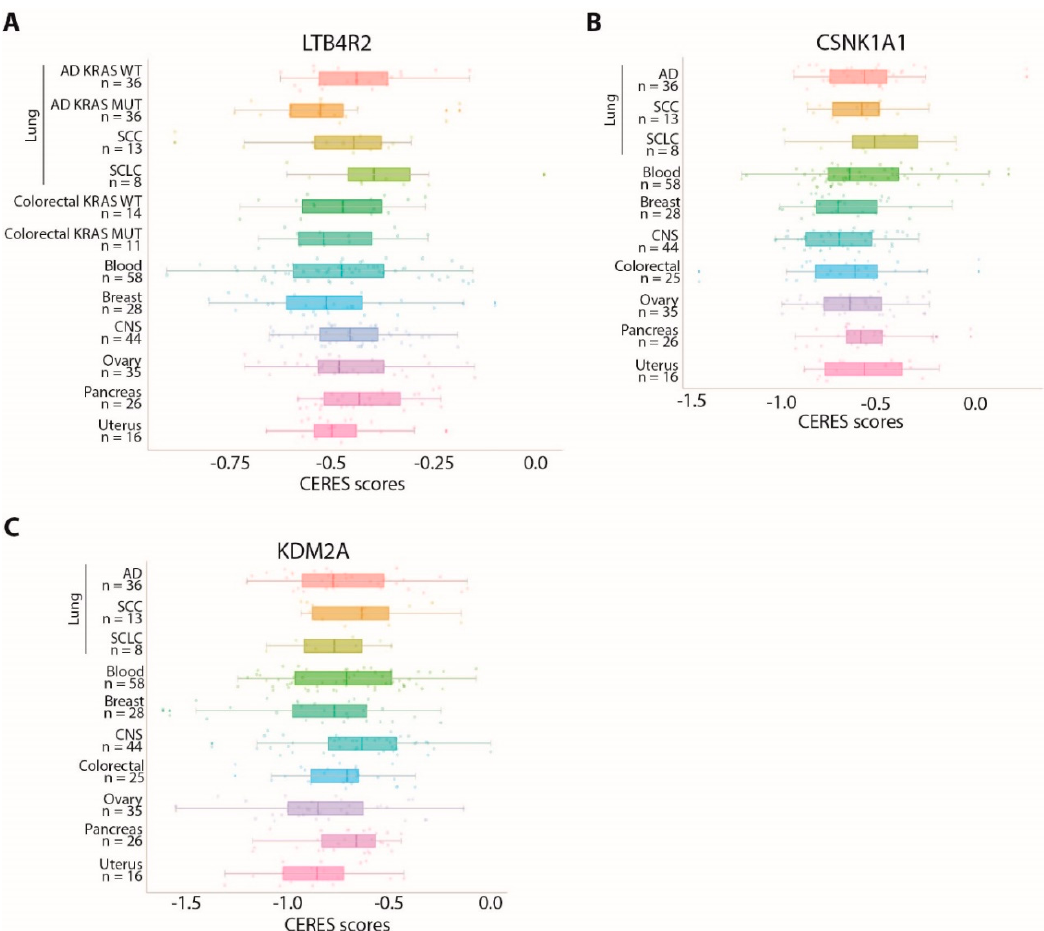
Figure 4. Cell lines derived from different tumor types show variable dependency on CSNK1A1, KDM2A, or LTB4R2: ( A – C ) comparison of CERES score distributions for the LTB4R2 ( A ), CNK1A1 ( B ), and KDM2A ( C ) genes in cell lines derived from different tumor tissues. The number of cell lines considered for each cancer type is indicated on the Y axis.